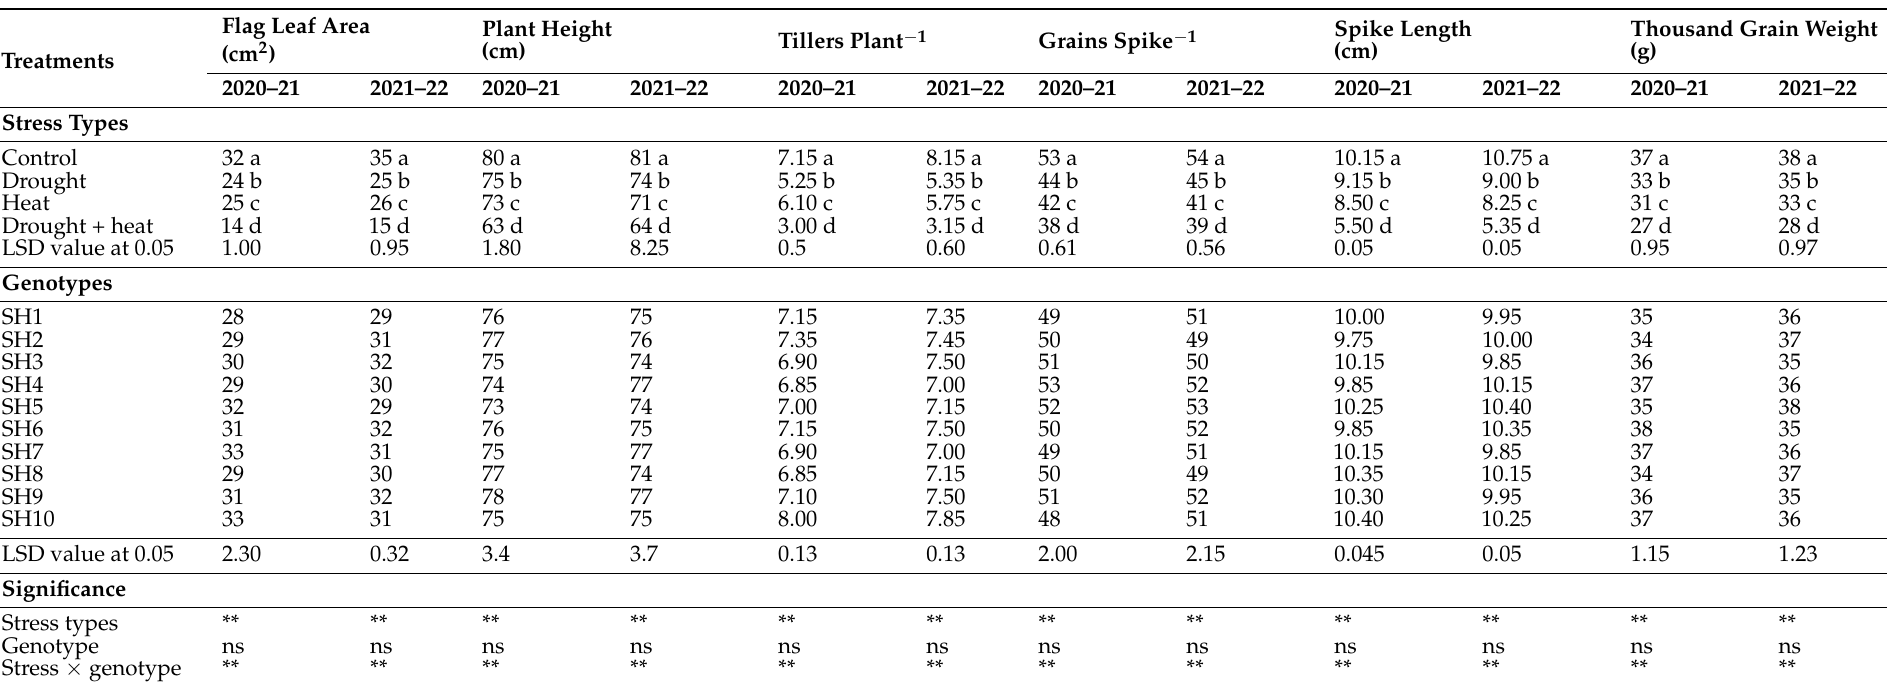
Table 5. Variation in agronomical parameters of different synthetic hexaploid wheat genotypes due to individual and combined application of drought and